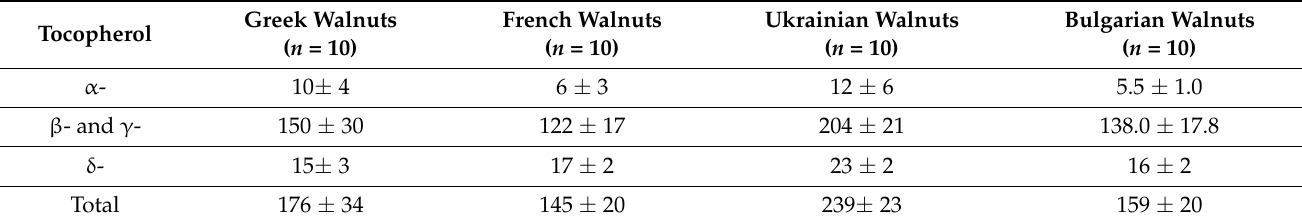
Table 6. Mean values ± SD (mg per kg of walnut seed oil) of